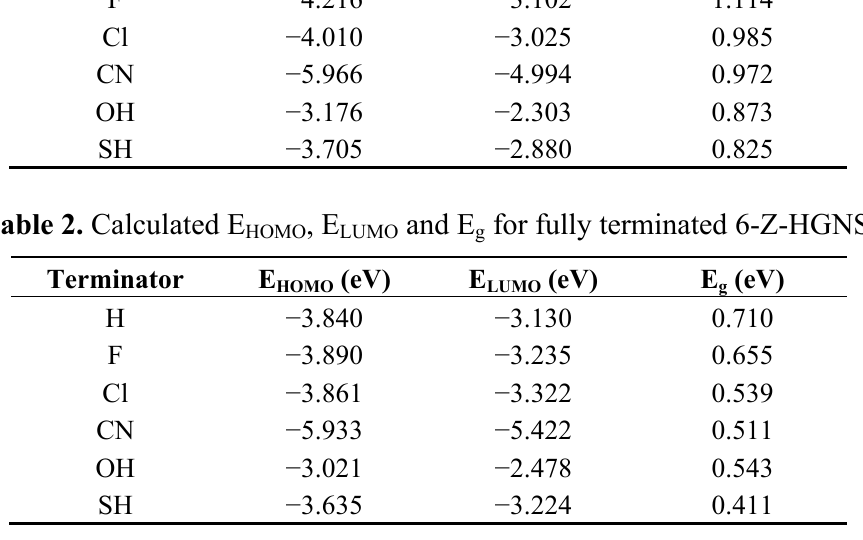
Table 1. Calculated E